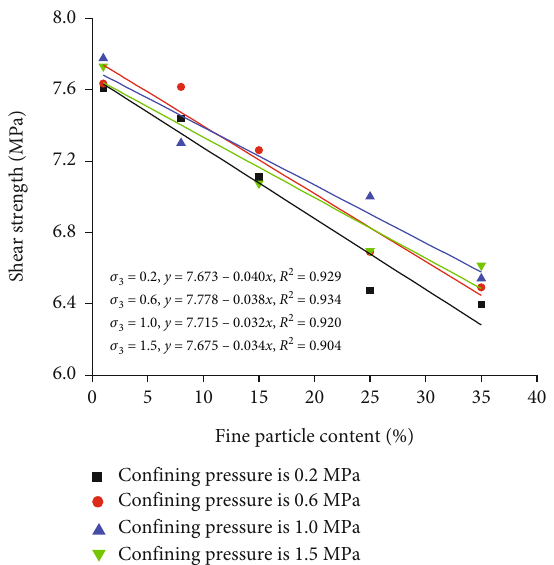
Figure 5: Variation curves of shear strength with fi ne particle